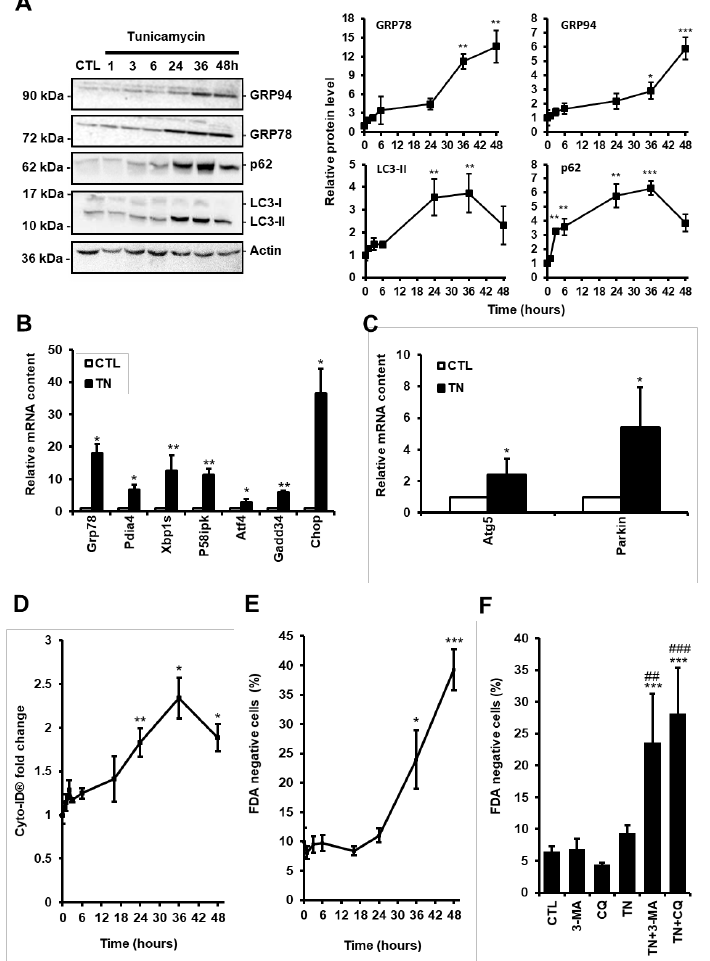
Figure 1. ( A ) H9c2 cells were treated with tunicamycin (TN, 10 µ g / mL) for the indicated times and the levels of endoplasmic reticulum (ER) stress (GRP94 and GRP78) and autophagic (p62 and LC3-II) markers were analyzed by Western blot. To block autophagosome content degradation, 50 µ M chloroquine (CQ) was added at the same time as tunicamycin (TN, 1 h) or 2 h before the end of tunicamycin treatment (TN, 3-48 h). Actin was used as a loading control. Relative protein levels are presented in graphs as mean ± S.E.M (n = 5). ( B , C ) Cells were left untreated or treated with tunicamycin (TN, 10 µ g / mL) for 16 h and the relative mRNA content of UPR target genes ( B ) or autophagy genes ( C ) was quantified by RT-qPCR and expressed as fold change over untreated controls. Values represent mean ± S.E.M. (n = 5). ( D ) Autophagy and cell death were monitored by flow cytometry in H9c2 cells treated or not with tunicamycin (TN, 10 µ g / mL) for the indicated times. Autophagy was detected after cell staining with Cyto-ID ® . Mean fluorescence intensity ± S.E.M is presented (n = 5). ( E ) The percentage of cell death was assessed by Fluorescein Diacetate (FDA) assay. Results presented in the graph are expressed as the percentage of dead cells (FDA negative cells) (mean ± S.E.M., n = 5). ( F ) H9c2 cells were left untreated or treated with 10 µ g / mL tunicamycin (TN) for 24 h ± 5 mM 3-Methyladenine (3-MA) or 50 µ M chloroquine (CQ) pretreatment and cell viability was determined. Results presented in the bar graph are expressed as mean ± S.E.M. of percentages of dead cells (FDA negative cells, n = 5). * P < 0.05, ** P < 0.01, *** P < 0.005 versus control. ## P < 0.01, ### P < 0.005 versus TN. According to the results of the kinetics presented here, autophagy was studied at 24 h and cell death at 48 h in the rest of our